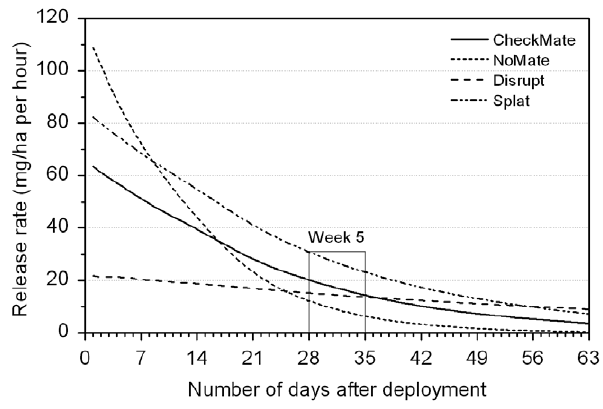
Figure 1. Effects of application of pheromone formulations on trap catch (percent disruption) of light brown apple moth. Note: Percent disruption is the difference in presence between ‘treated’ and ‘controls’ expressed as a percentage of the ‘control’ (values are based on back-transformed covariate-adjusted percent moth presence in traps – see Fig. S3). Results shown are for traps at 1.5 m above ground. Data for weeks 11–13 are based on very low catches at the end of the flight period and percent disruption in those weeks should be interpreted with caution.